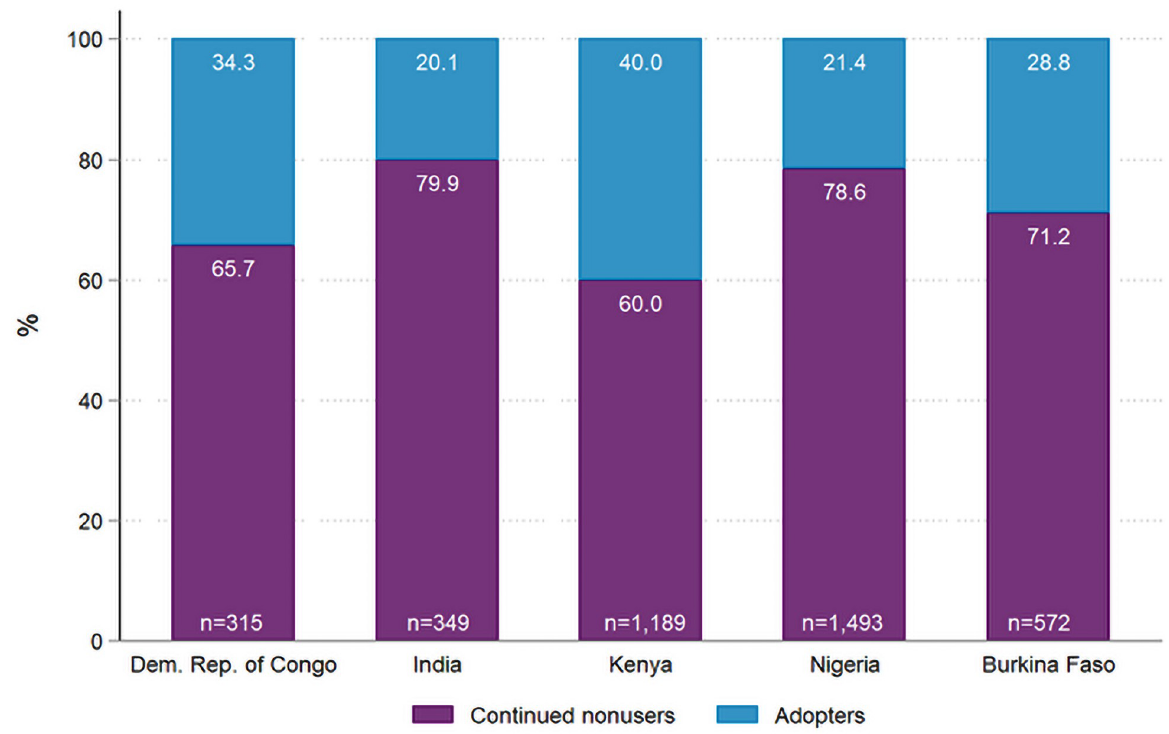
Fig 1. Percentages of continuing non-users and adopters in the Democratic Republic of Congo, India, Kenya, Nigeria, and Burkina Faso, PMA Agile 2017–2020.